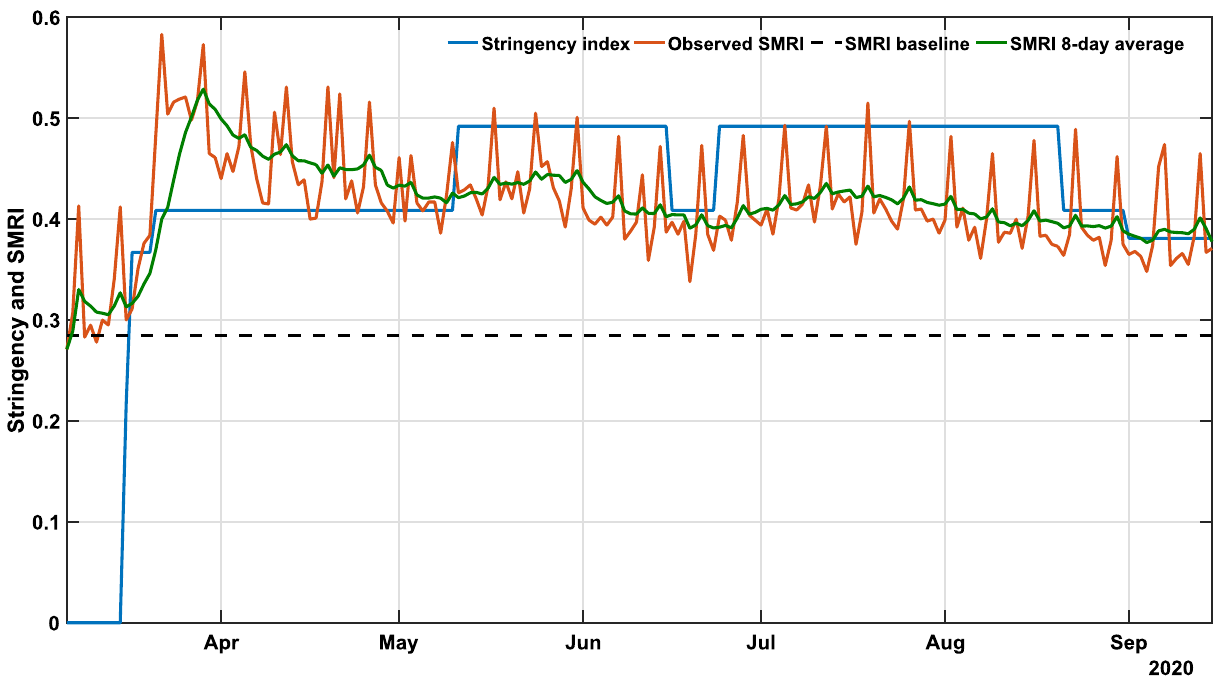
Figure 1. COVID-19 governmental polices and population response. The plot shows the stringency (blue), social mobility reduction (orange) indexes and its 8-day average (green) in Bahia. Raw data from March 6 to September 15, 2020 are shown in this graph. The dashed horizontal line represents the baseline SMRI average between February 1-28, 2020, indicating the level of popular circulation in a pre-COVID